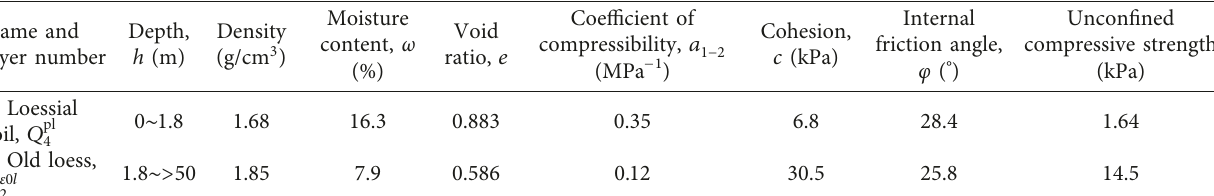
Figure 2: Indoor and field tests. (a) Moisture content test. (b) Compression test. (c) Direct shear test. (d) Unconfined compressive strength test. (e) Static cone penetration test. Table 1: Physical properties of the soil layers.